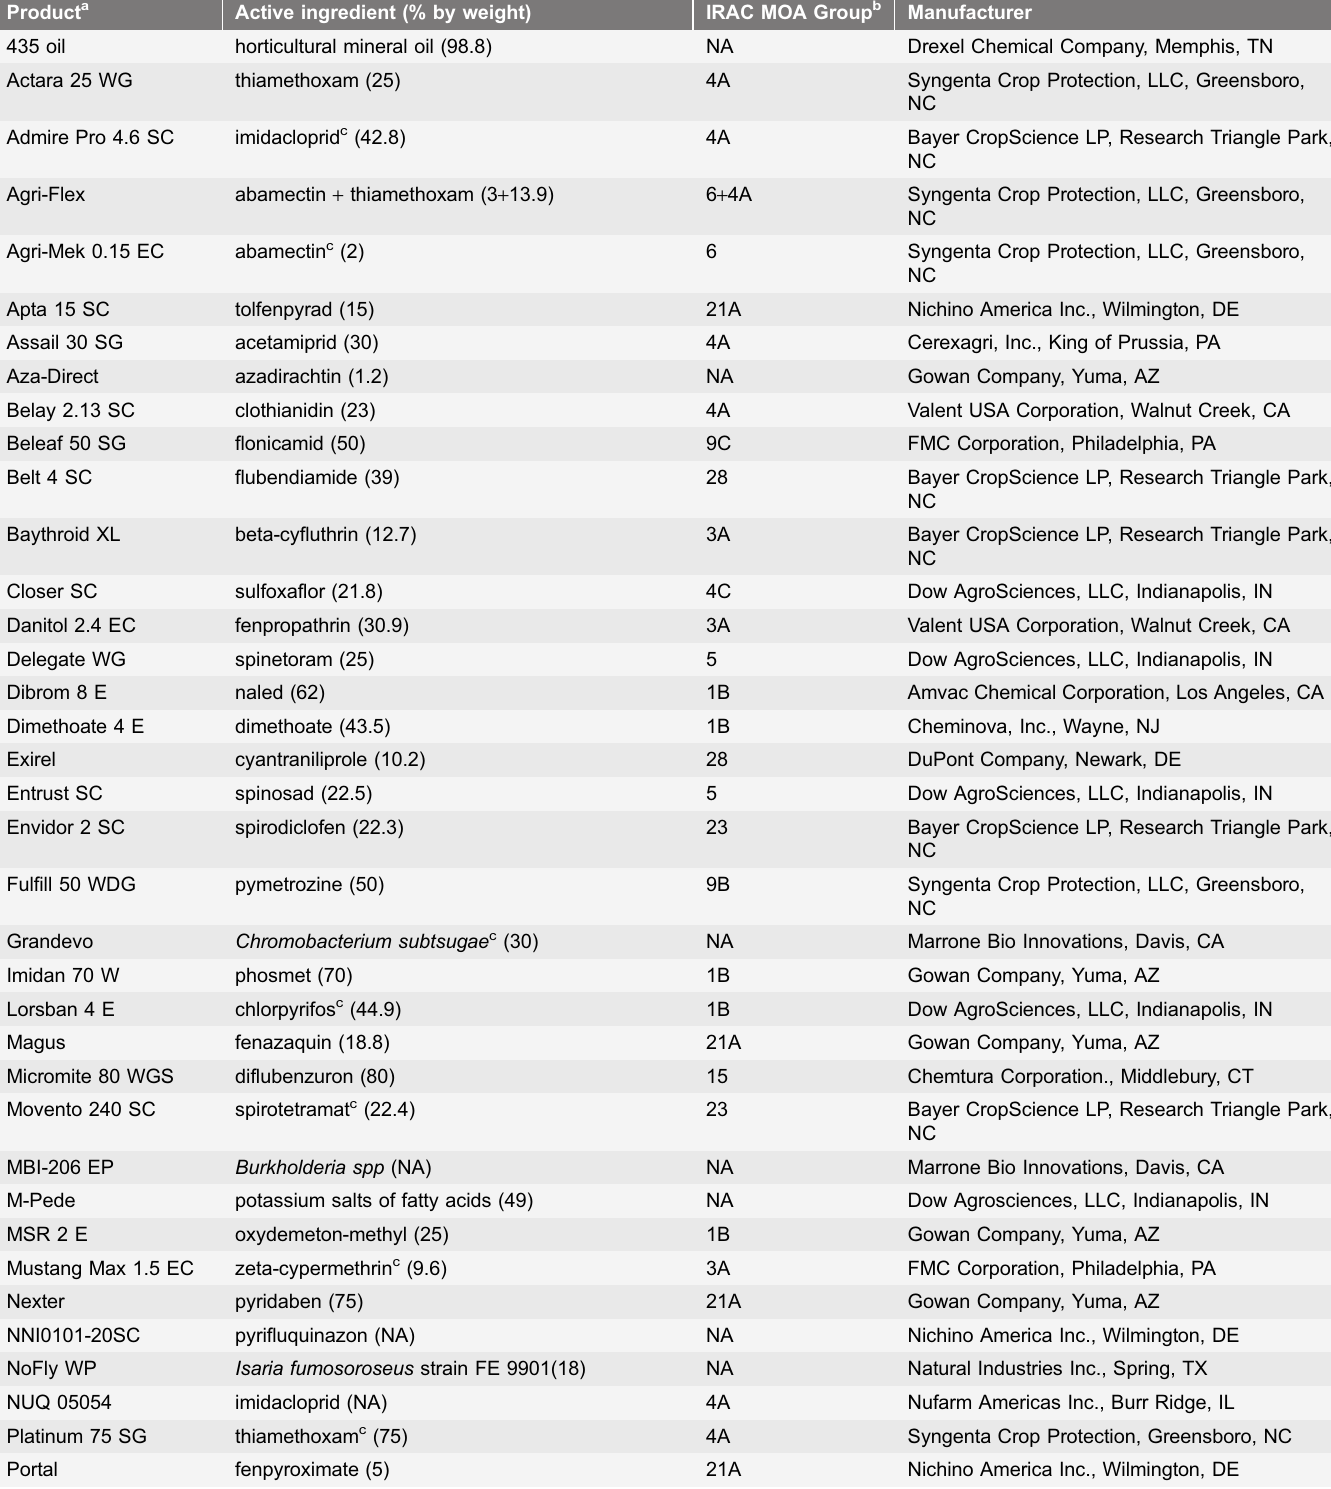
Table 1. Name, active ingredient, mode of action group and manufacturer of the products tested as foliar spray or soil application against Diaphorina citri